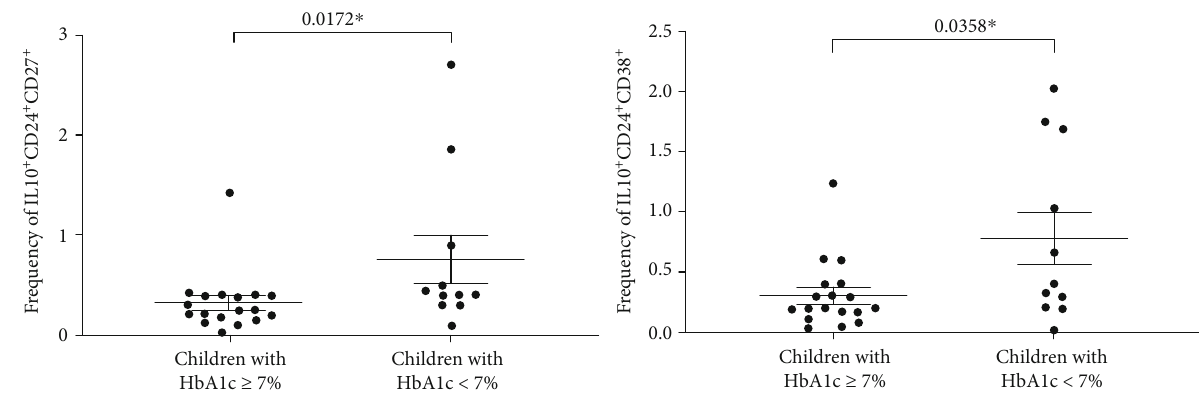
Figure 3: Frequency of B10 and immature transitional Breg subsets according to children ’ s HbA1c levels. Horizontal lines show means ± standard error . ∗ indicate signi fi cance ( P < 0 : 05